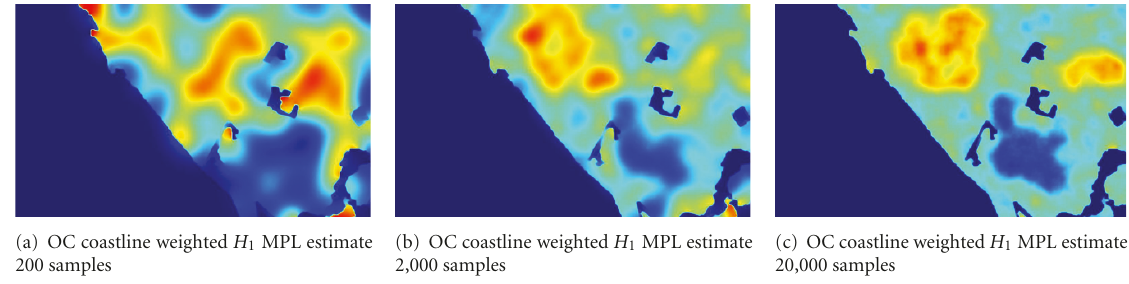
Figure 9: These images are the Weighted H 1 MPLE estimates for 200, 2,000, and 20,000 sampled events of the Orange County Coastline example. The color scale for these images are located in Figure